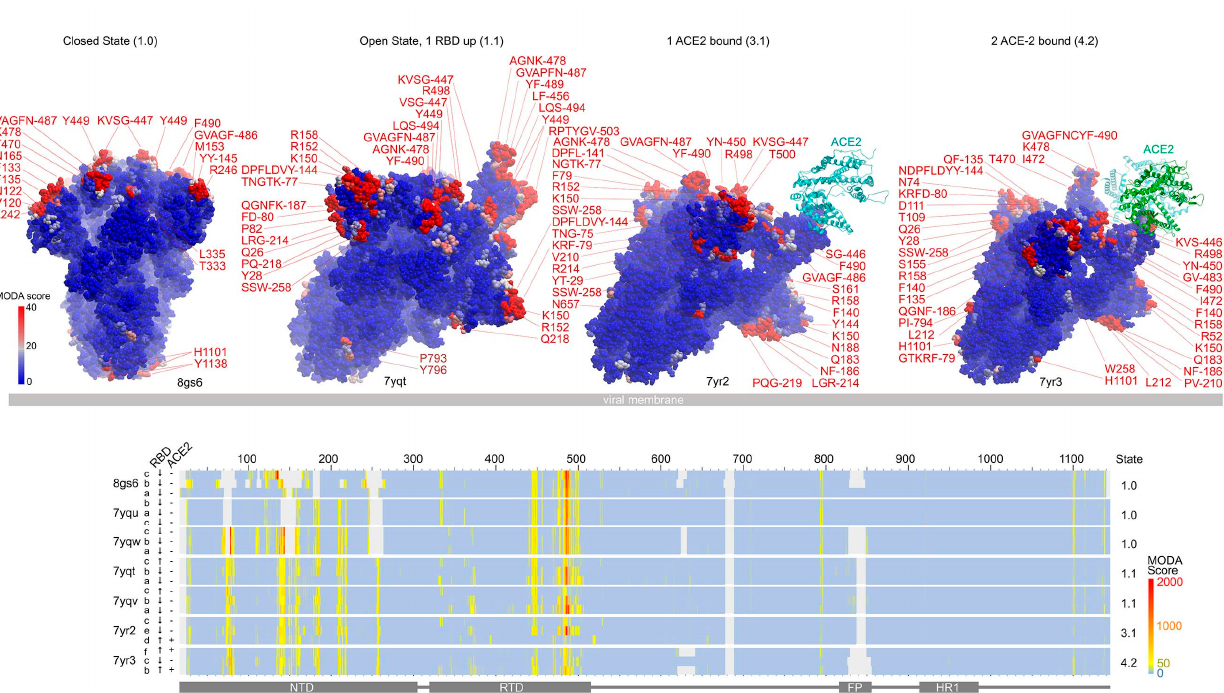
Figure 3. Comparison of membrane binding by BA.2.75 spike conformational states. ( A ) The residues with moderate (pink) and substantial (red) membrane binding propensities in the SARS-CoV-2 variant BA.2.75’s spike protein trimer in its progressive closed, open, and singly and doubly ACE-2 bound states (PDBs: 8gs6, 7yqt, 7yr2, 7yr3) are shown in the side views from left to right. The viral membrane is shown as a grey slab, and the spike trimer is tilted to position host membrane binding interfaces above. Residues are labelled and coloured pink-red based on MODA scores of 20–40+. ( B ) The heatmap shows the membrane binding propensities of S residues. RBD position and ACE-2 occupancy are labelled left of the map, and the S state is on the right. Positions are coloured light blue–yellow–red to indicate MODA scores from 0-50-2000, as in the lower right scale, while grey indicates missing positions in the PDB files. The positions of the NTD, RBD, fusion peptide (FP), and heptad repeat 1 (HR1) are shown below.